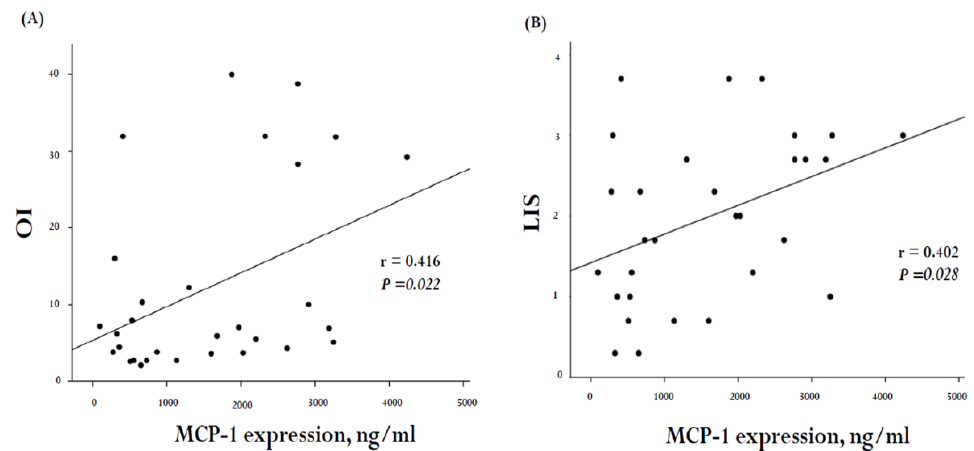
Figure 3. Correlation of plasma MCP-1 levels with severity of pulmonary dysfunction score in 30 VAP subjects. ( A ) There was a signification correlation between MCP-1 levels and OI (general linear model, r = 0.416, p = 0.022, n = 30) as well as ( B ) lung injury scores (LIS) (general linear model, r = 0.402, p = 0.028, n = 30).